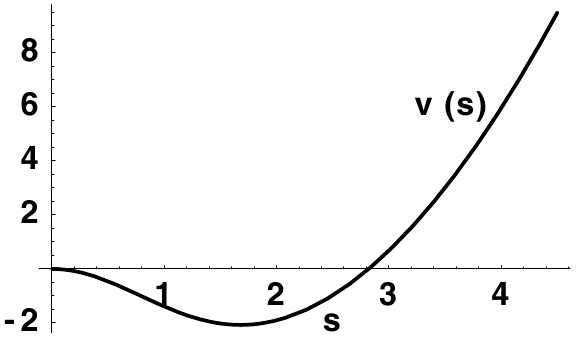
FIG. 12. The dimensionless space-charge potential v (cid:2) s (cid:3) pro- duced by a frozen, cylindrically symmetric beam distribution with (cid:7) (cid:4) 3